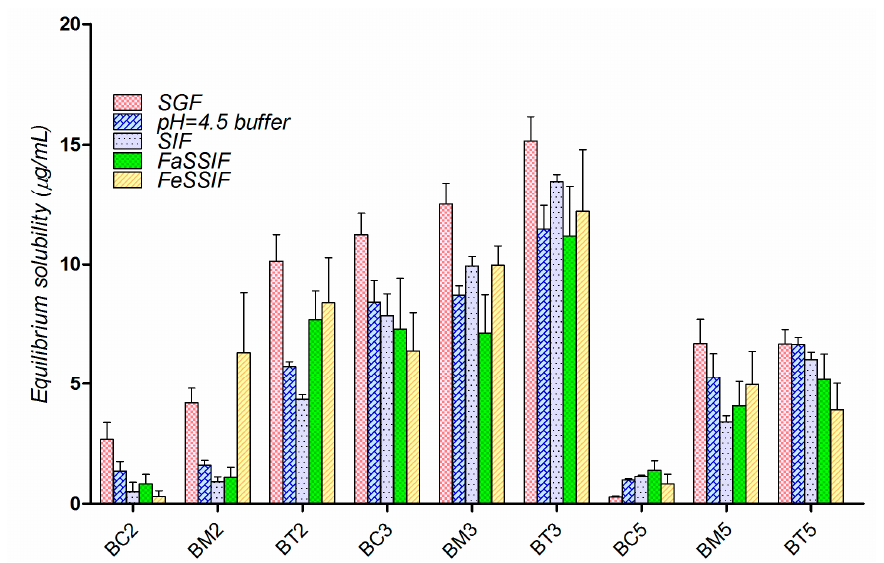
Figure 4. Solubility of the tested compounds in simulated gastro-intestinal fluids ( μ g/mL), at 25 °C (mean for three